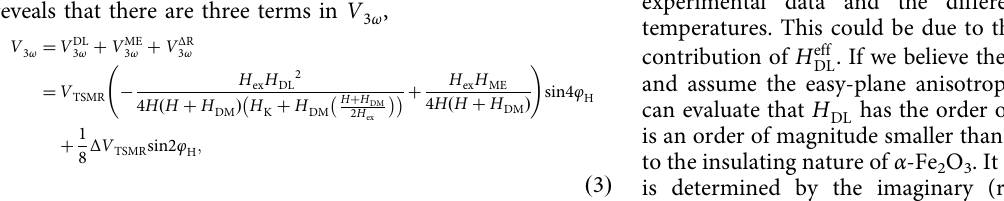
Fig. 1e. From the fi tting, we obtain H consistent with previous reports, while the Oersted fi eld contribu- tion in our Hall cross is only ~5 Oe 9 .